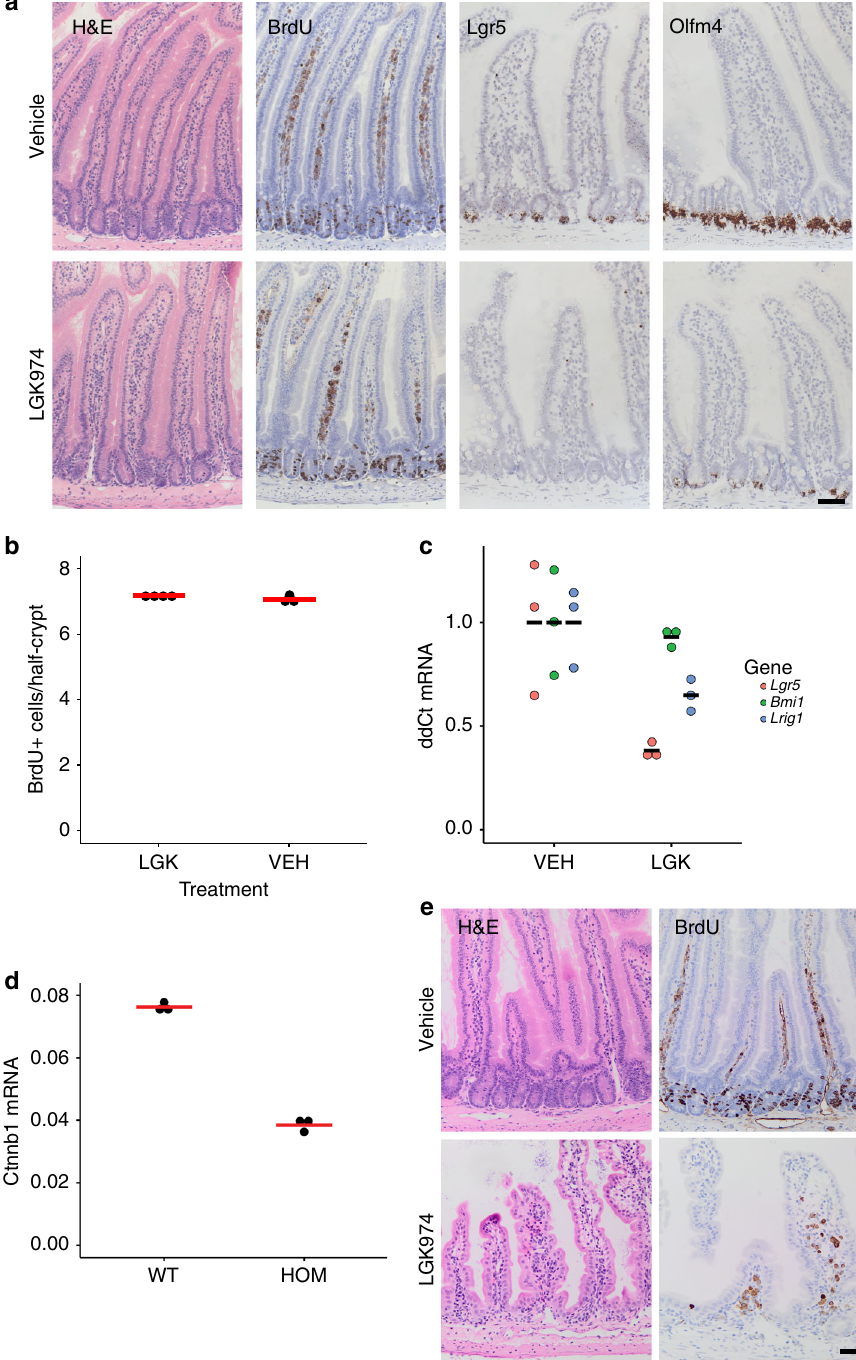
Fig. 1 Homoeostasis is unperturbed after LGK974 treatment. a C57BL/6 mice were treated with LGK974 for 4.5 days. The small intestine showed no toxicity and no difference in proliferation (BrdU). Treatment of LGK974 leads to downregulation of the intestinal stem cell genes Lgr5 and Olfm4 as con fi rmed by RNA in situ hybridisation. Note only a few cells at the bottom of the crypt still express Olfm4 after LGK974 treatment ( N = 3 for both groups). b Quanti fi cation of BrdU + cells/half-crypt (at least 30 crypts per mouse were analysed). Each dot represents the average per mouse, red bar = mean per group. Vehicle (VEH) N = 3, LGK974 (LGK) N = 4. c qRT-PCR con fi rms downregulation of several stem cell genes, whereas expression of Bmi1 is unchanged. Each dot represents single mouse sample, black bar indicates mean per group, N = 3 per group. d Uninduced Catnb lox(ex3)/lox(ex3) are hypomorphs with about 50% reduced expression of β -catenin ( Ctnnb1 ), as con fi rmed by qRT-PCR ( N = 3). e Reduced expression of β -catenin results in hyper-sensitivity to LGK974 and loss of the (small) intestinal crypts within 10 days (mean survival), N = 8. Scale bar = 50 µ